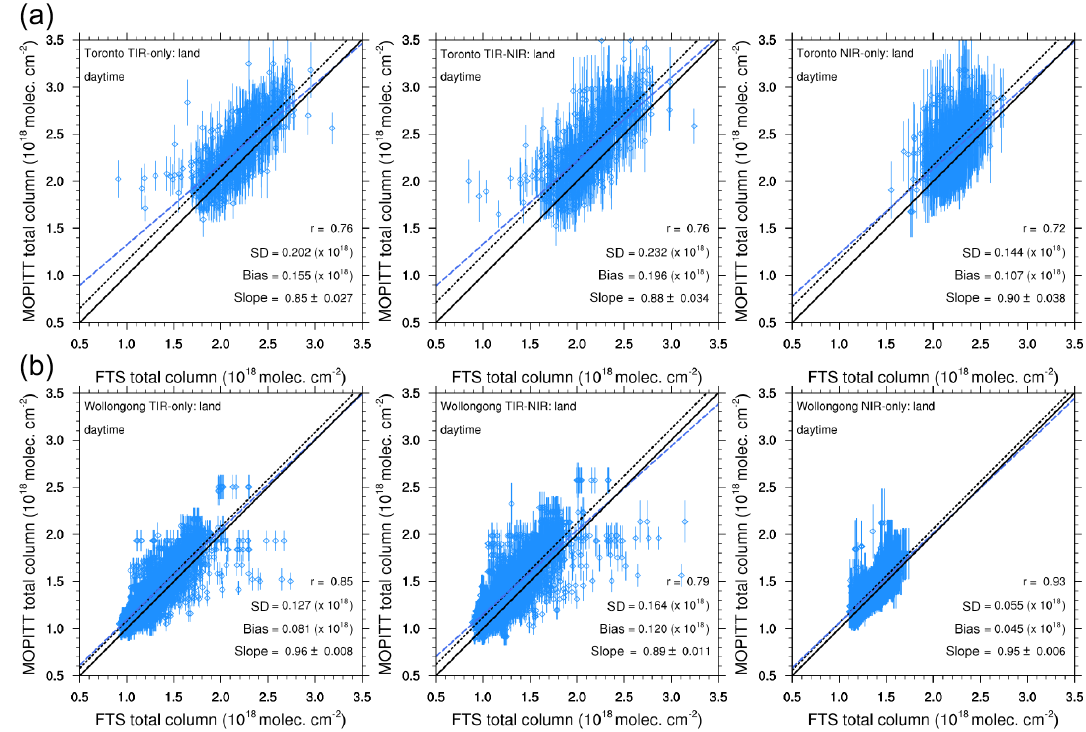
Figure 4. Example of the correlation plots at Toronto (a) and Wollongong (b) . Daytime, land-only pixels are shown for each retrieval type TIR-only, TIR–NIR, and NIR-only. The black dotted line indicates mean bias and the blue dashed line indicates correlation regression line. For reference, the 1 : 1 line is indicated in solid black. Error bars are the errors for MOPITT values, combined in quadrature from the pixels within a 1 ◦ radius of the station. Column amounts are moleculescm − 2 . Table 4. Validation results for MOPITT water pixels for V6 thermal and joint products at stations which had approximately equal represen- tation by water and land pixels. Values for land validation are in Table 3a, b, and c. Mean bias is expressed as percent relative to FTS values. Bold text indicates significant drift where p < 0 . 01, determined from a two-tailed t